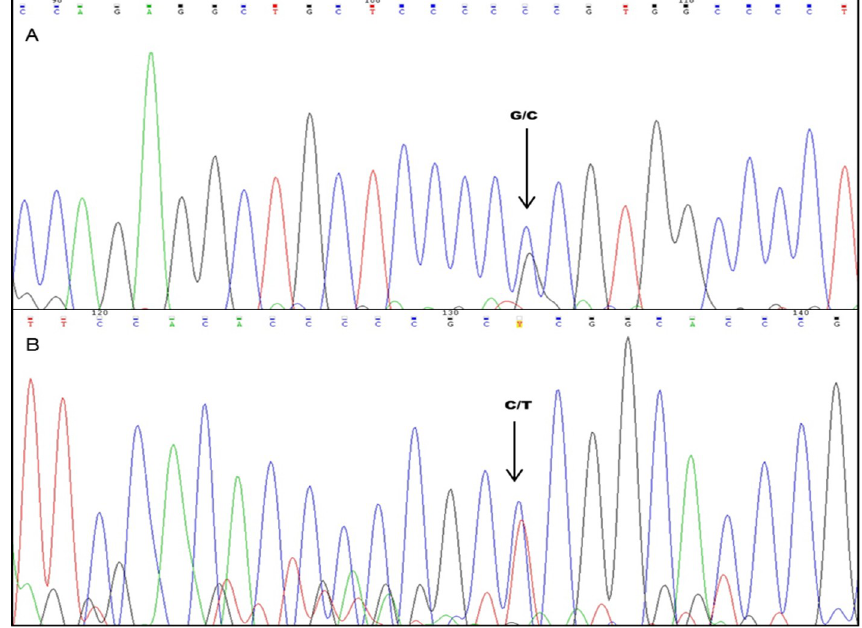
Figure 2. Nucleotide changes identified in TP53 . ( A ) G → C polymorphism at codon 72 of exon 4 (Arg/Pro) ( B ) C → T transition mutation at codon 153 of Exon 5 (Leu/Pro).